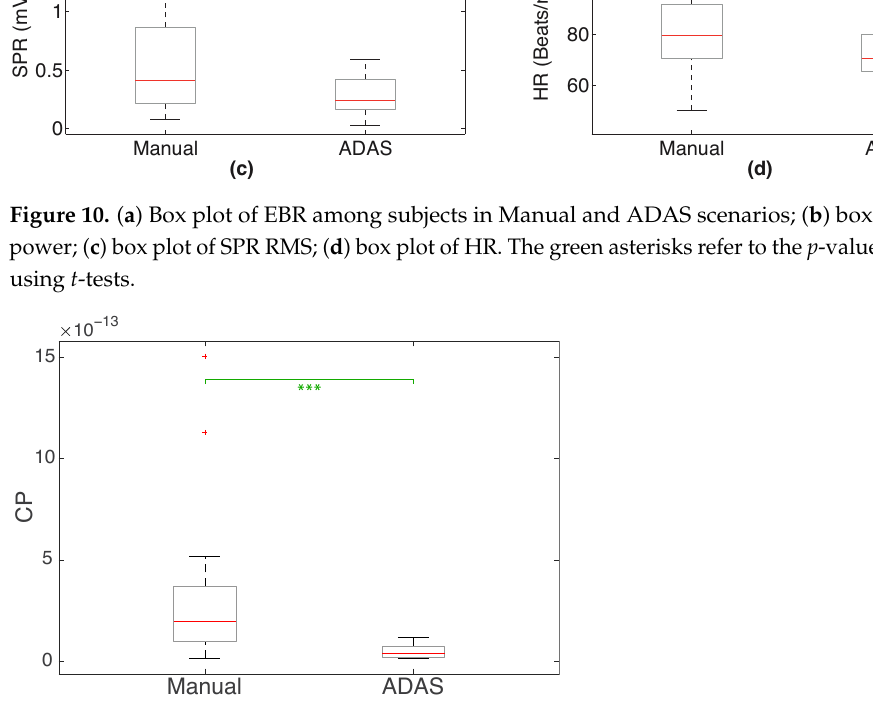
Figure 11. Box plot of the CP parameter (SPR RMS × mean HR × beta power/EBR, with SPR in mV, HR in Beats Per Minute, beta power in µ V 2 , and EBR in Blinks Per Minute) among subjects in the Manual and ADAS scenarios. The red lines correspond to the medians, the boxes to the first and third quartiles, the whiskers to the values based on the Interquartile Range (IQR) computation, and the plus sign markers to the outliers. The green asterisks refer to the p -values computed with the Wilcoxon test. Table 4. Paired t -test probability p -value considering Manual versus ADAS scenarios using different physiological measurements (EBR, beta power, SPR RMS, and mean HR) computed for all